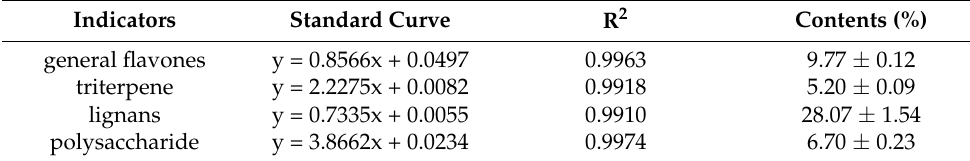
Table 2. Contents of main chemical constituents of K. coccinea fruit extract (n =